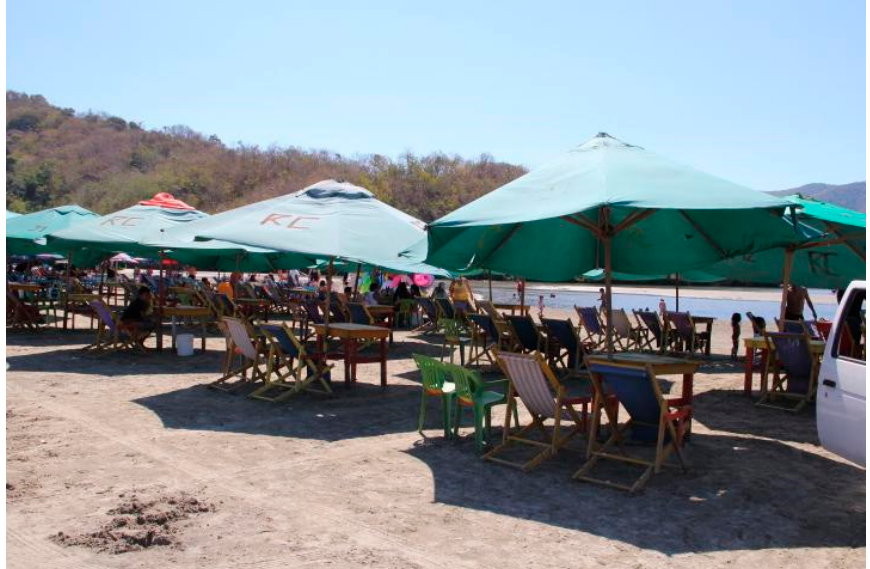
Figure A1. La Boquita Beach in holiday season (above and below). (Photos Omar Cervantes, Ricardo Guzman).